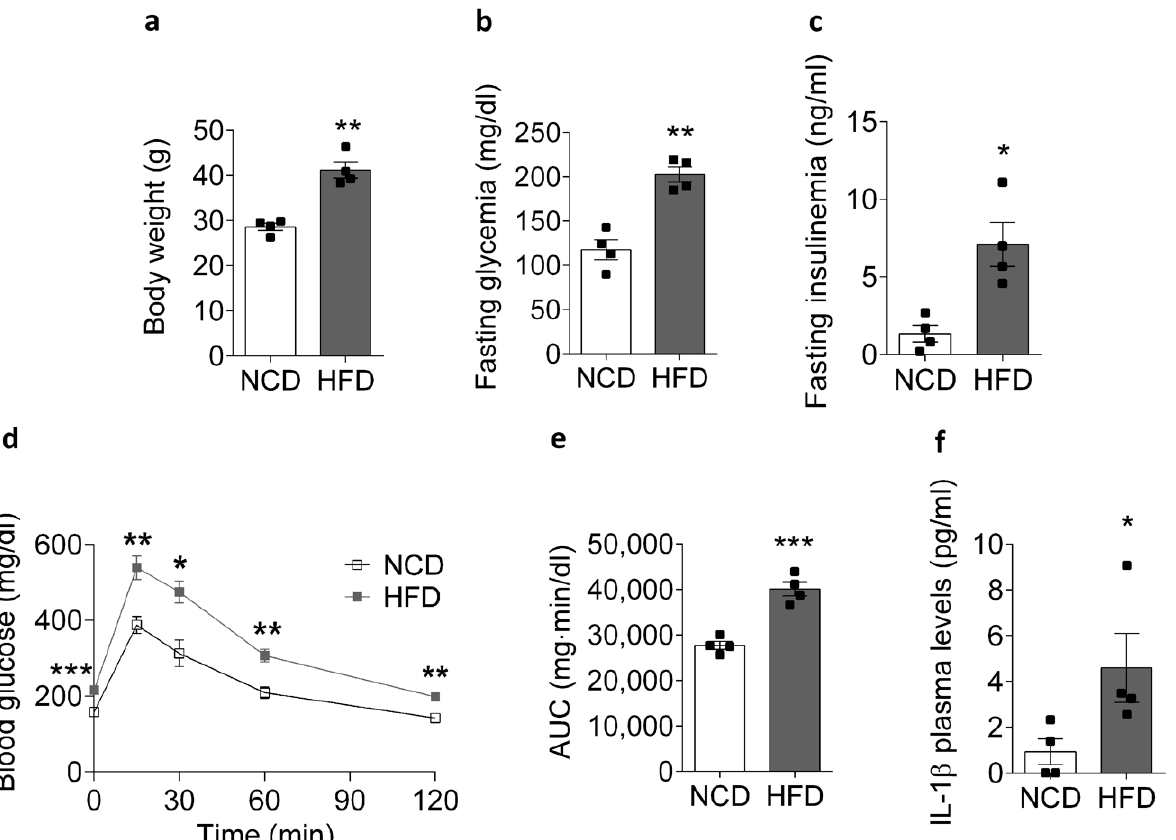
Figure 1. Physiological and metabolic parameters of NCD- and HFD-fed mice. Comparison of ( a ) body weight, ( b ) fasting blood glucose, ( c ) plasma insulin, ( d ) intraperitoneal glucose tolerance test, ( e ) area under the glucose curve, and ( f ) IL-1 β in mice fed for 8 weeks with an NCD or HFD. Data are shown as the mean ± SEM. * p < 0.05 ( n = 4), ** p < 0.01, and *** p < 0.001 vs. HFD. NCD, normal control diet; HFD, high-fat diet.